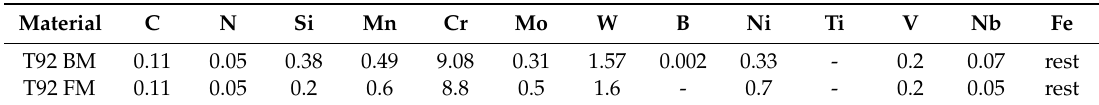
Table 1. Chemical composition (wt.%) of T92 base material (T92 BM) and T92-based filler metal (T92 FM) used for fabrication of T92 / T92